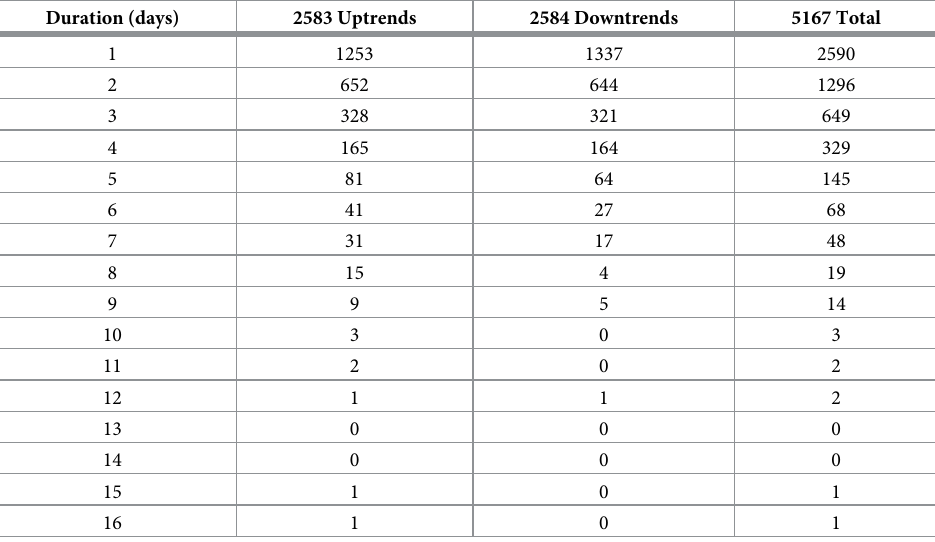
Table 5. Composition of uninterrupted trends observed in Nikkei index.